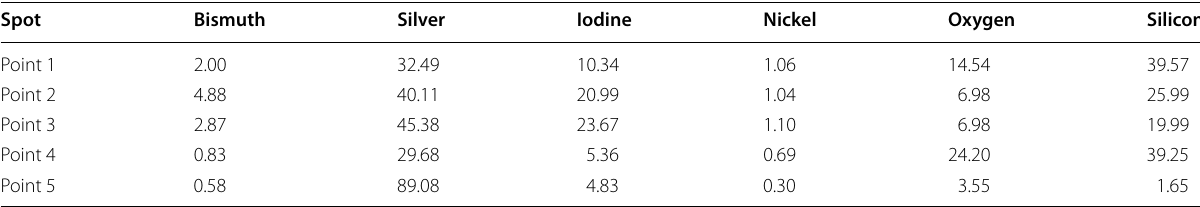
Table 9 Elemental distribution (atomic %) of the individual elements observed on a particular spot on Ag strate shown in Fig. 8b